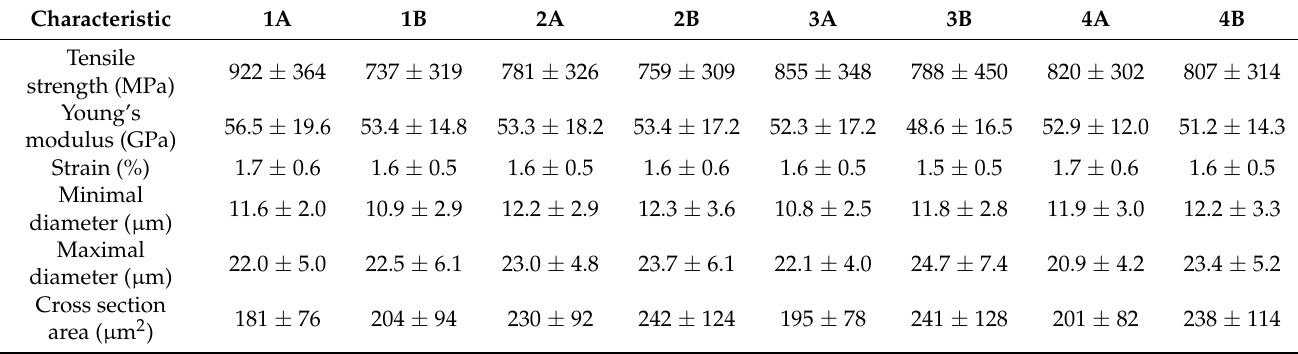
Table 8. Tensile properties, minimal diameter, maximal diameter and cross-section area of individ- ual fibres coming from the four studied batches and tested after extraction, using both methods A and B.